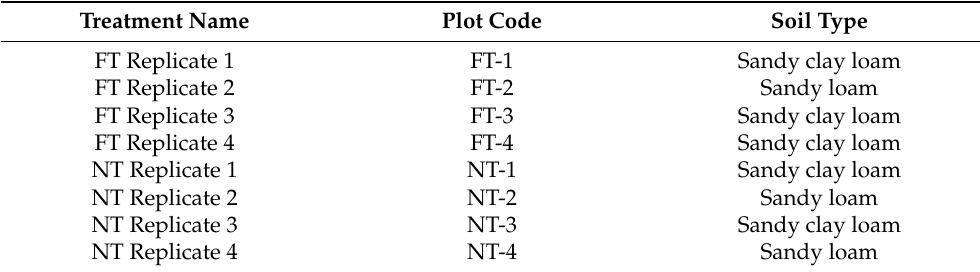
Table 6. Predominant soil type for soil layers of the FT and NT treatment plots in 2007 at Maricopa,